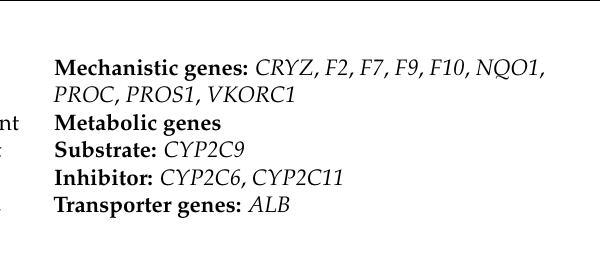
Table 3. Pharmacogenomics of antithrombotic drugs.